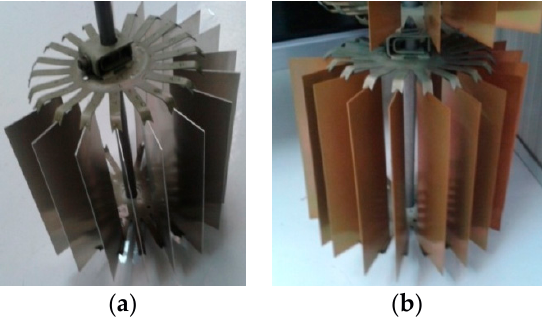
Figure 2. Aluminium plates: ( a ) before and ( b ) after chromic acid anodization with Alodine 1200S.